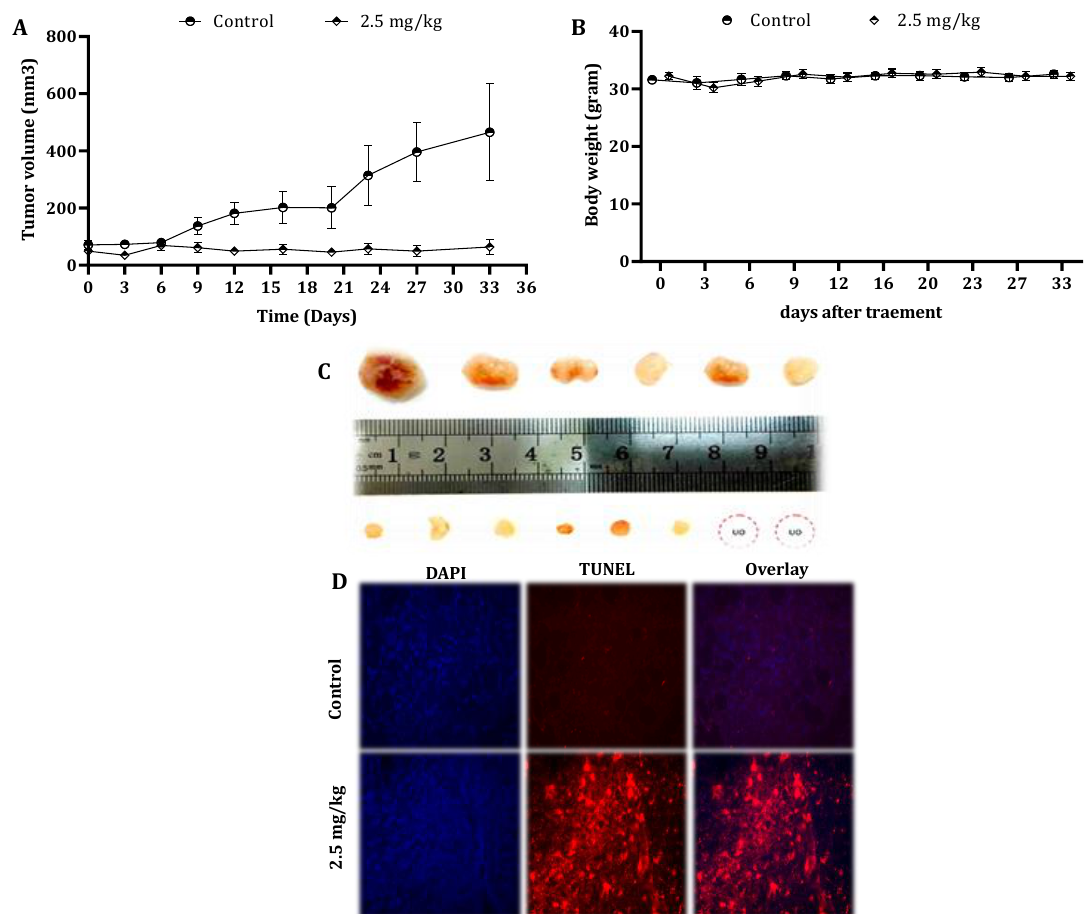
Figure 6. Effect of CSE on the tumor growth of human pancreatic cancer cells in xenograft mice. Nude mice were subcutaneously implanted with 2 × 10 6 PL45 cells. When the tumors reached a volume of around 50 mm 3 , mice were randomly divided into two groups: control: n = 6 and treatment: n = 8. The mice were treated once a week by the intravenous injection of either DMSO to the control group or CSE at a concentration of 2.5-mg/kg body weight for 5 weeks. During the experi- ments, tumor volumes ( A ) and body weights ( B ) were measured twice a week. The results presented are the mean ± SE. Statistical significance was determined by a mixed model repeated-measures ANOVA, p < 0.05. Representative tumors from the control and treated mice indicated the inhibition effect of CSE on tumor growth (UO = unobserved) ( C ). Paraffin- embedded tissue sections were prepared from the tumor tissues (control and CS-treated mice), and DAPI and TUNEL staining was performed. Tumor tissues were analyzed under fluorescent microscopy. The TUNEL-positive (orange) cells are apoptotic cells, nuclei are labeled with DAPI (blue) and the merge between DAPI and TUNEL appears pink (magnifi- cation, 400×) ( D ).